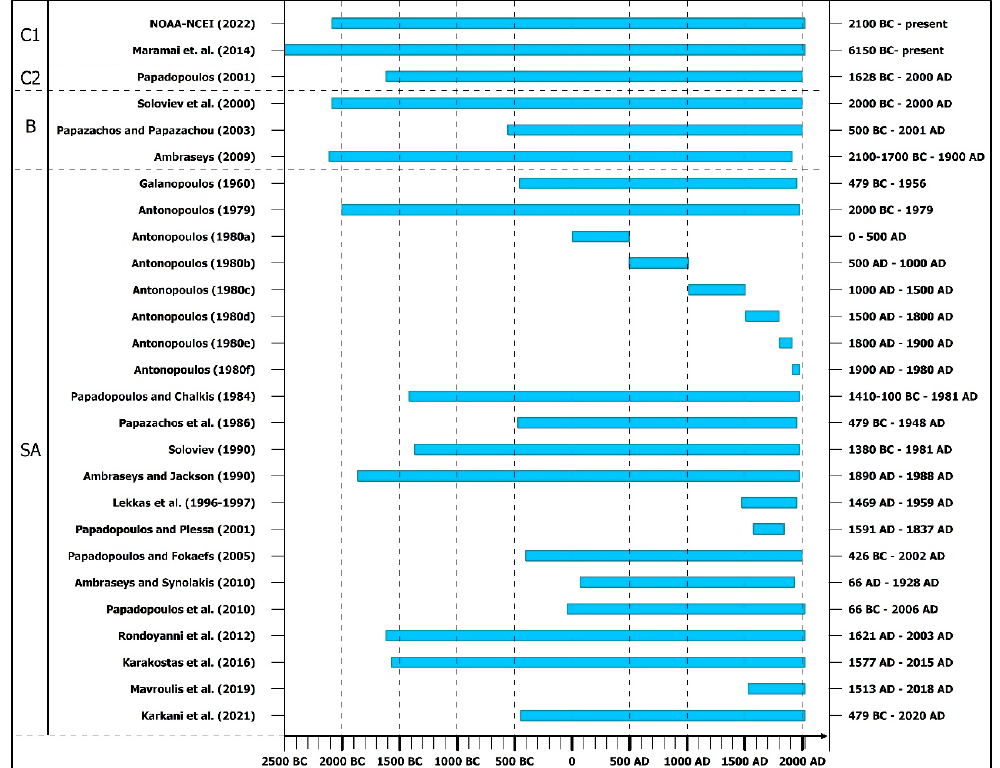
Figure 2. The main tsunami-related sources [33,37–39,41–49,52–63,65] for the study area used in